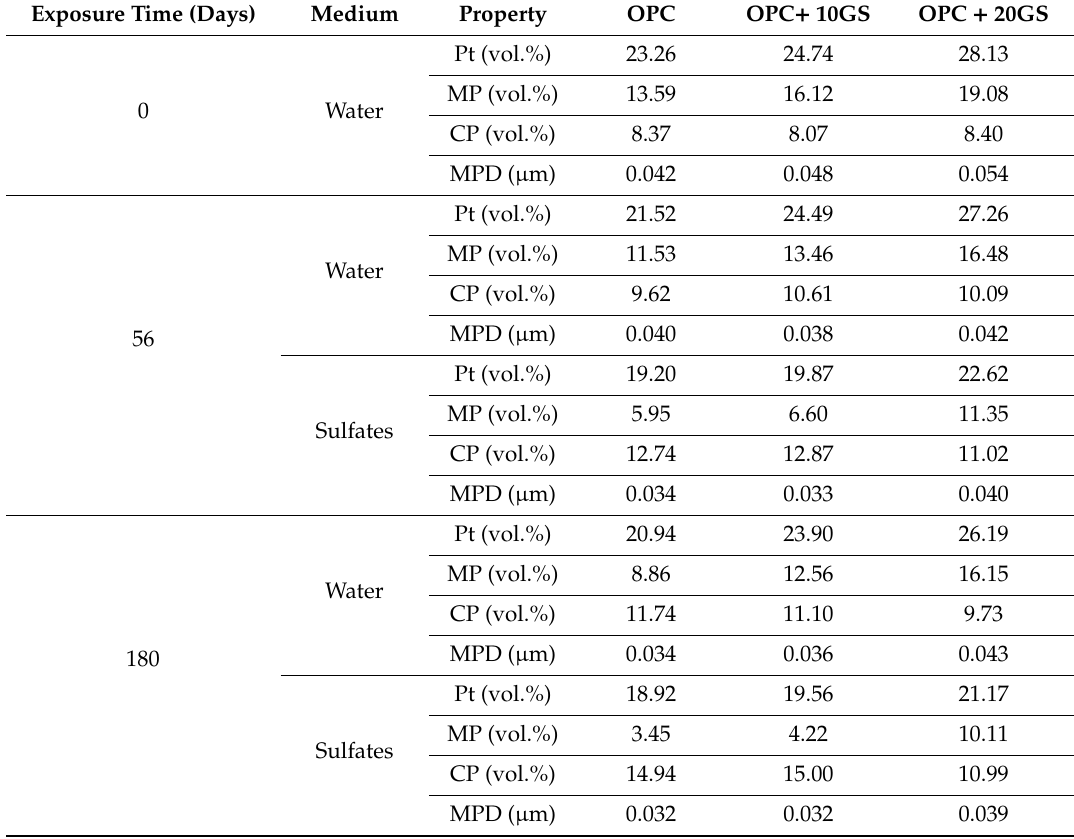
Table 3. Pore system properties.